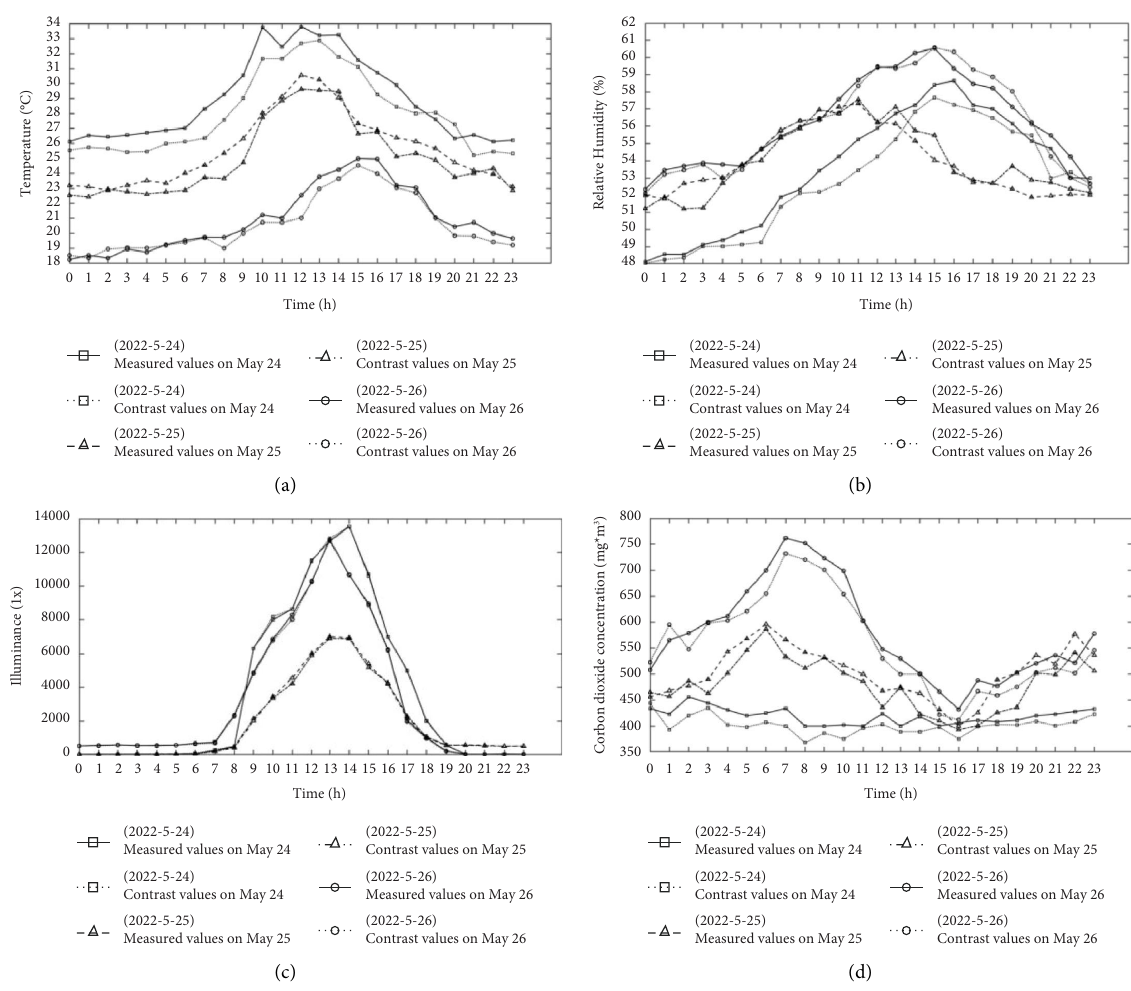
Figure 16: Comparison of measured values and comparison values of the environmental data. (a) Comparison of temperature data. (b) Comparison of relative humidity data. (c) Comparison of light intensity data. (d) Comparison of carbon dioxide concentration data.